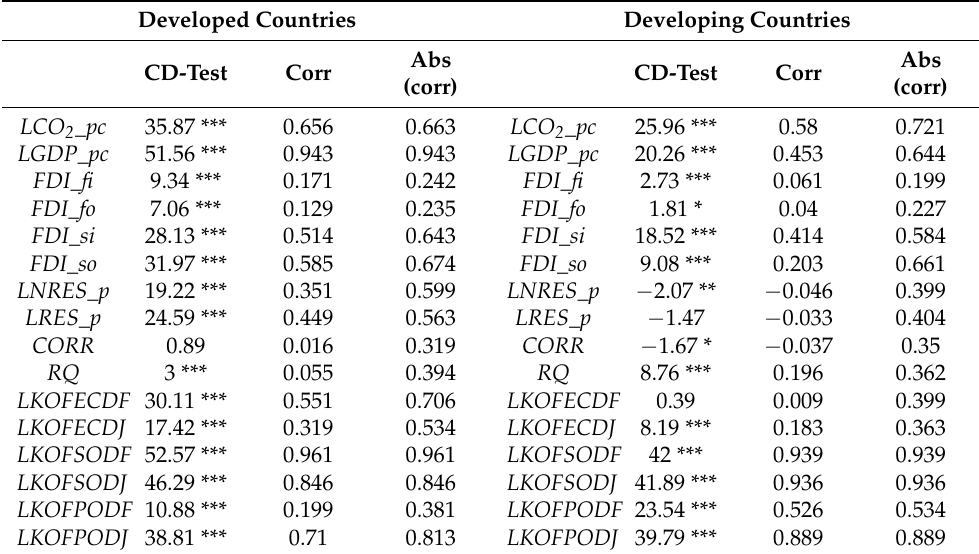
Table 5. Cross section dependence test from 1996 to 2017 (CO 2 model).